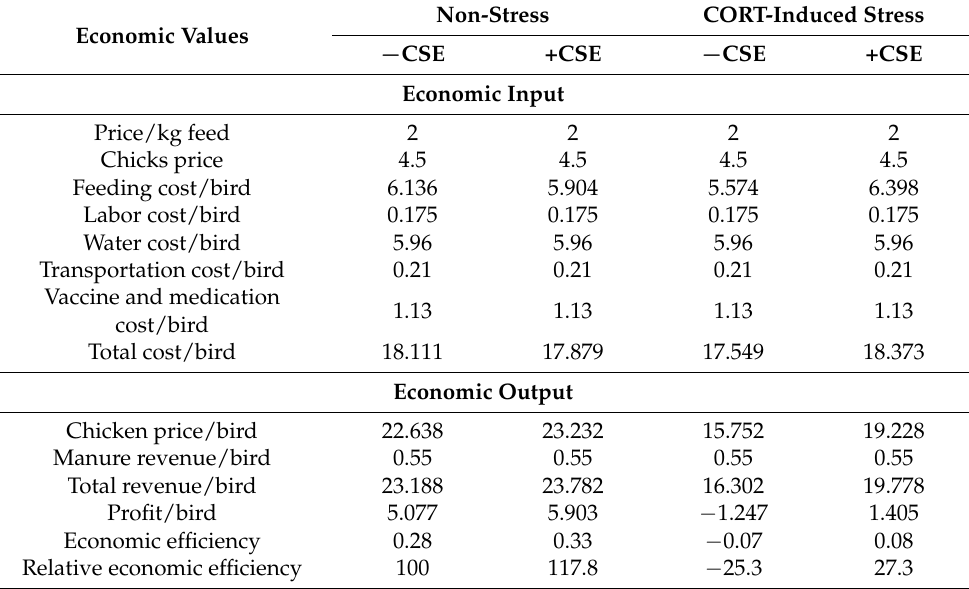
Table 6. Economic efficiency of broiler chickens fed corn silk extract (CSE) and subjected to corticosterone-induced oxidative stress